Question: What style of plot is this figure drawn as?
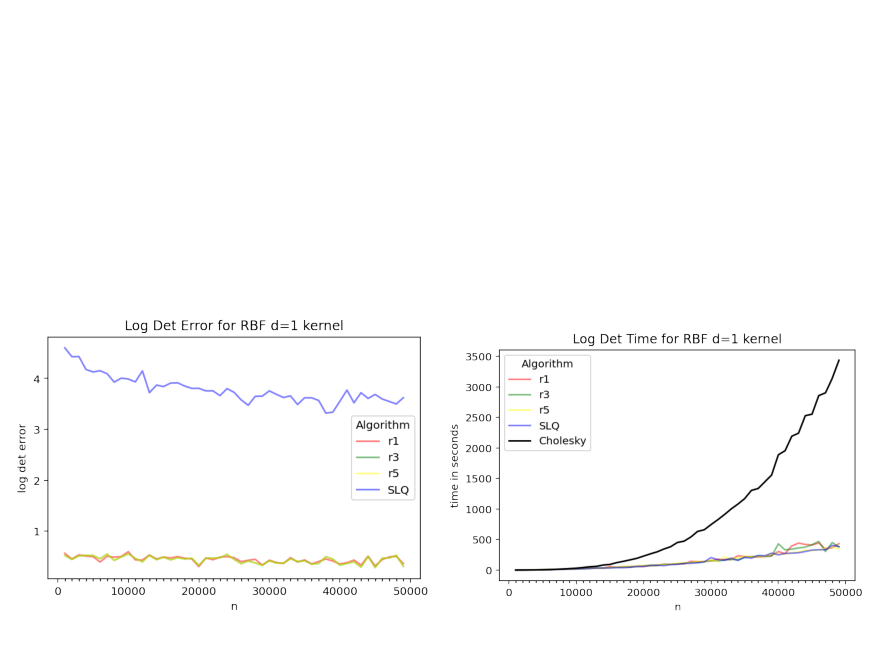
Answer: line